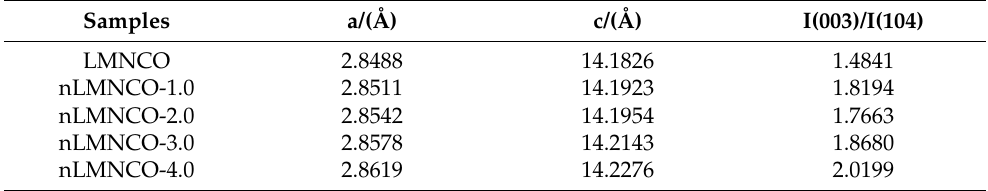
Table 1. Refined lattice parameters and ratio of characteristic peak intensities of cathode